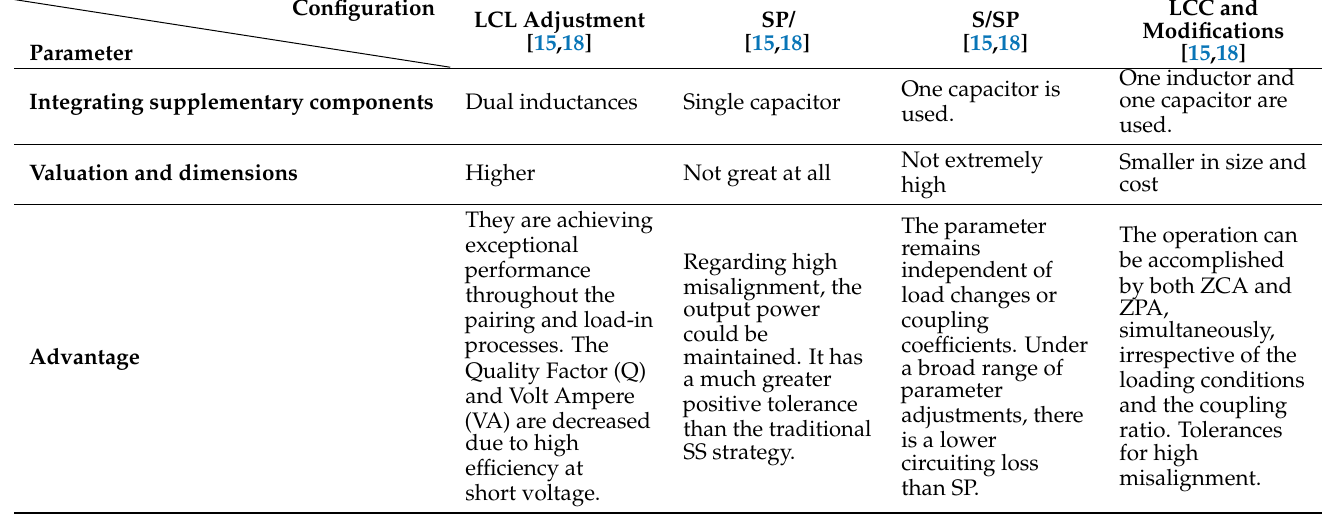
Table 3. Comparative analysis of complex hybrid topologies for recommended